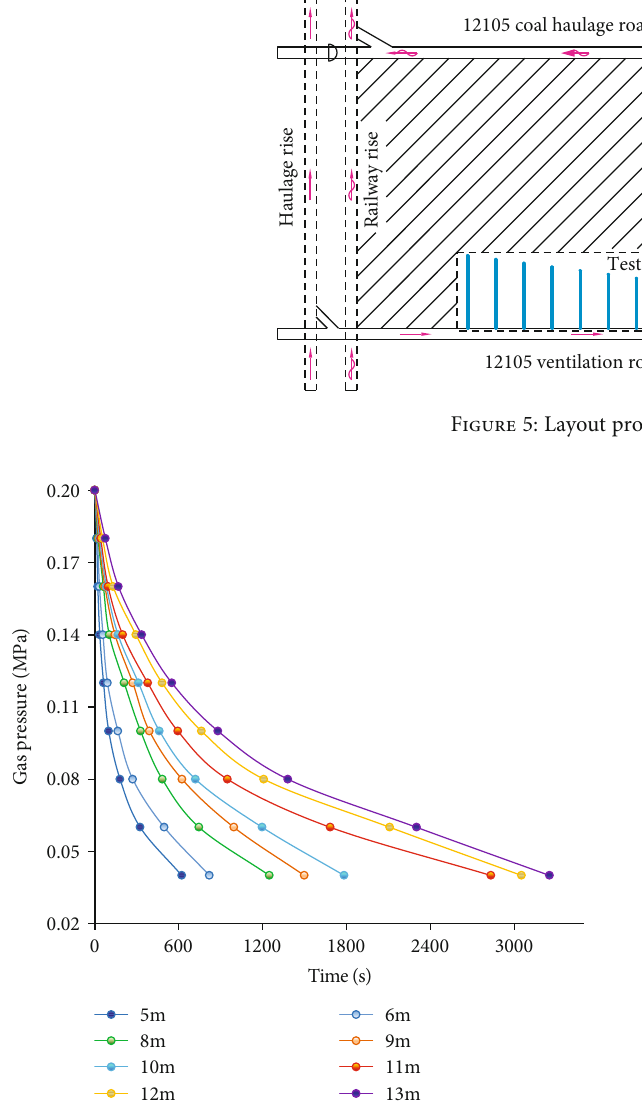
Figure 6: Gas pressure change as time in boreholes at di ff erent depths.